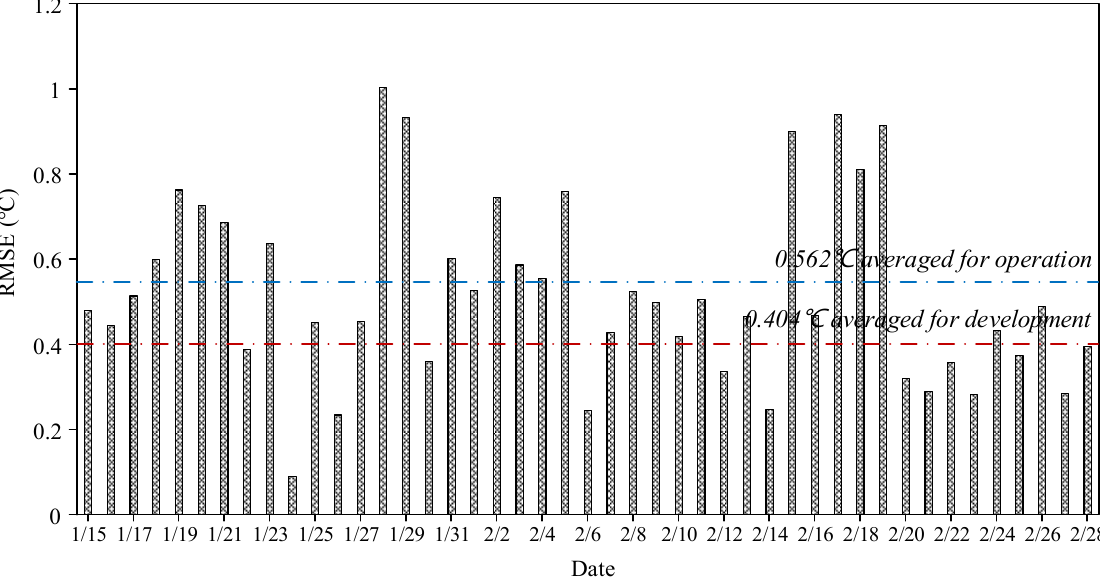
Figure 4. The daily RMSE distribution of the target virtual sensor in the whole operation period.